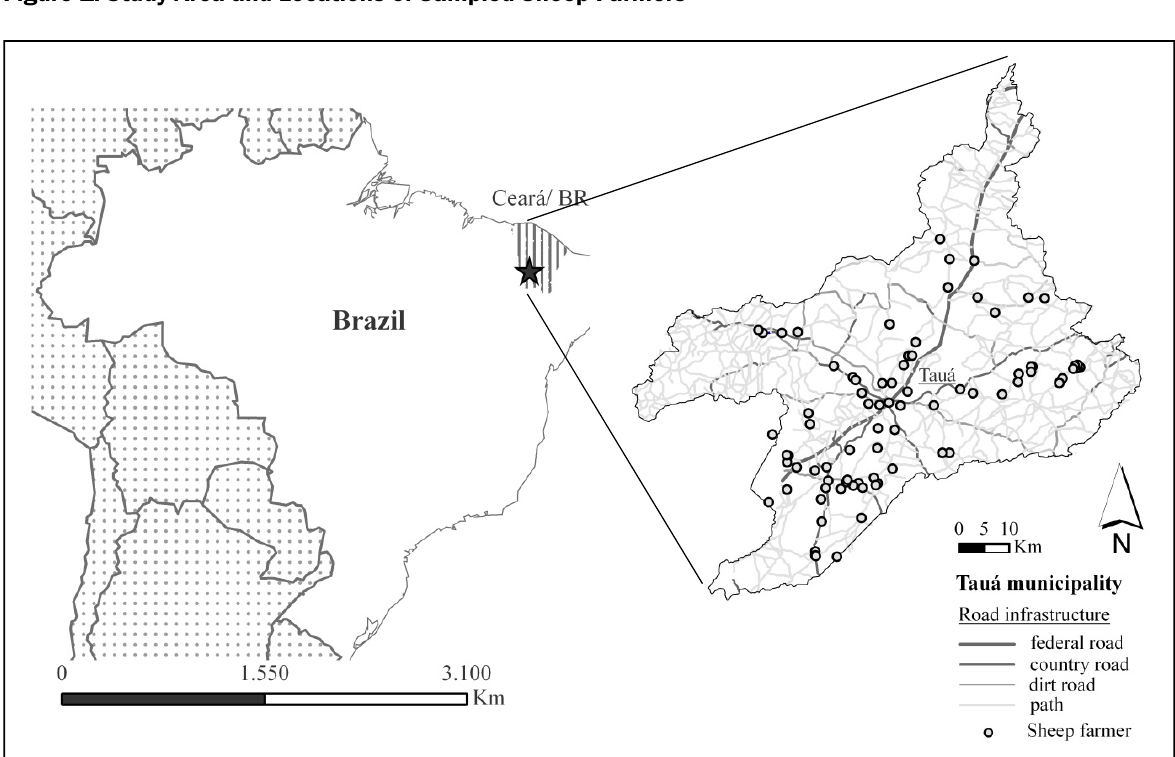
Figure 1. Study Area and Locations of Sampled Sheep